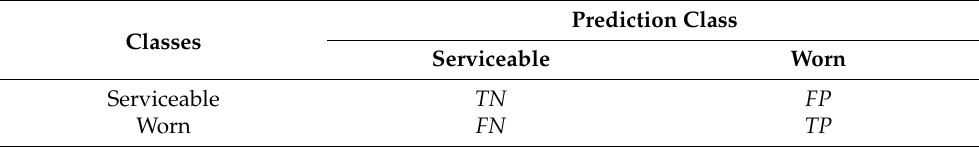
Table 1. Confusion